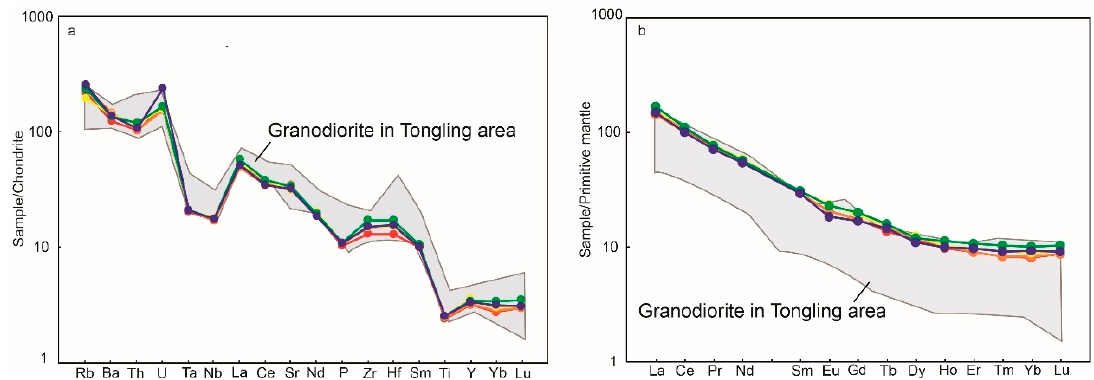
Figure 5. Classification diagrams of lithochemical compositions of Hucunnan granodiorites: ( a ) Total alkali vs. silica (TAS) [49]; ( b ) K 2 O–SiO 2 [50]; ( c ) A/NK vs. A/CNK [51]. Ir—The Irvine dividing line, the top is alkaline, and the bottom is sub-alkaline; SHO—Potassium basalt series; H-K—High potassium calcium basic series; CA—Calc-alkaline series; IAT—Low potassium series.